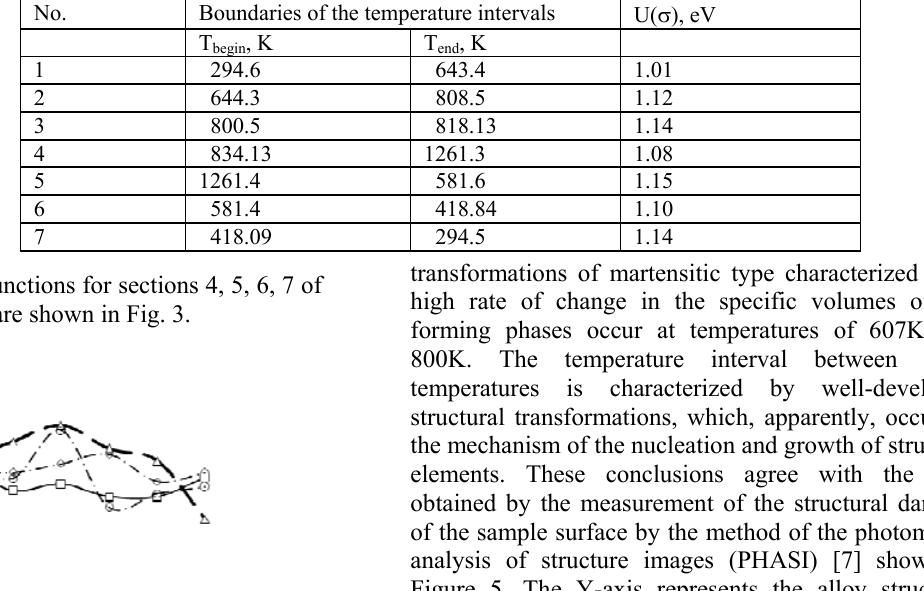
Table 1. Temperature intervals of the monotonic behavior of dilatometric curve and the corresponding average values of the effective activation energies